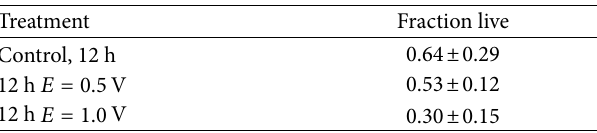
Errors are standard deviations of three independent measurements ( 푁 = 3